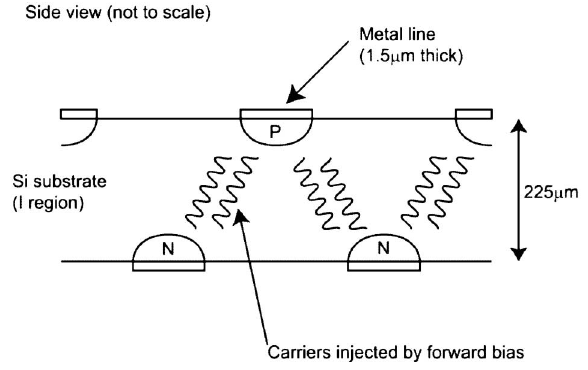
FIG. 10. Side view of p - i - n (cid:1) n - i - p diode active